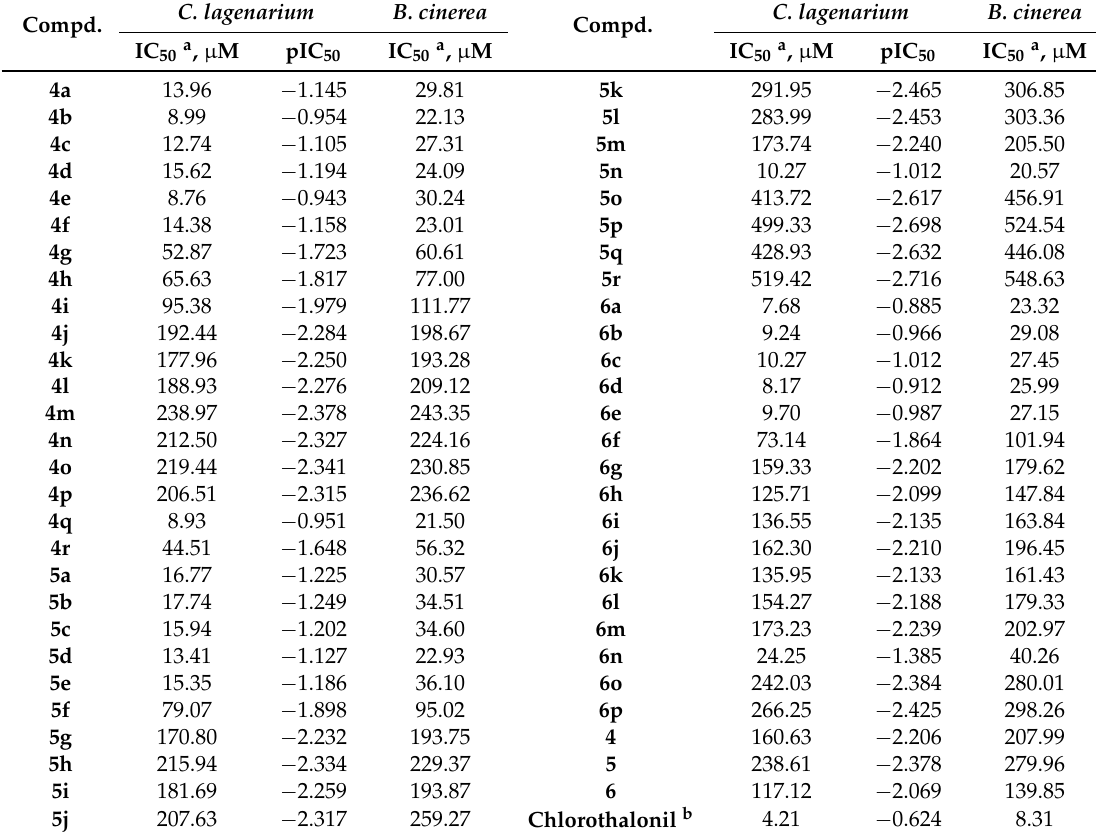
Table 1. In vitro fungicidal activity of compounds against C. lagenarium and B. cinerea .